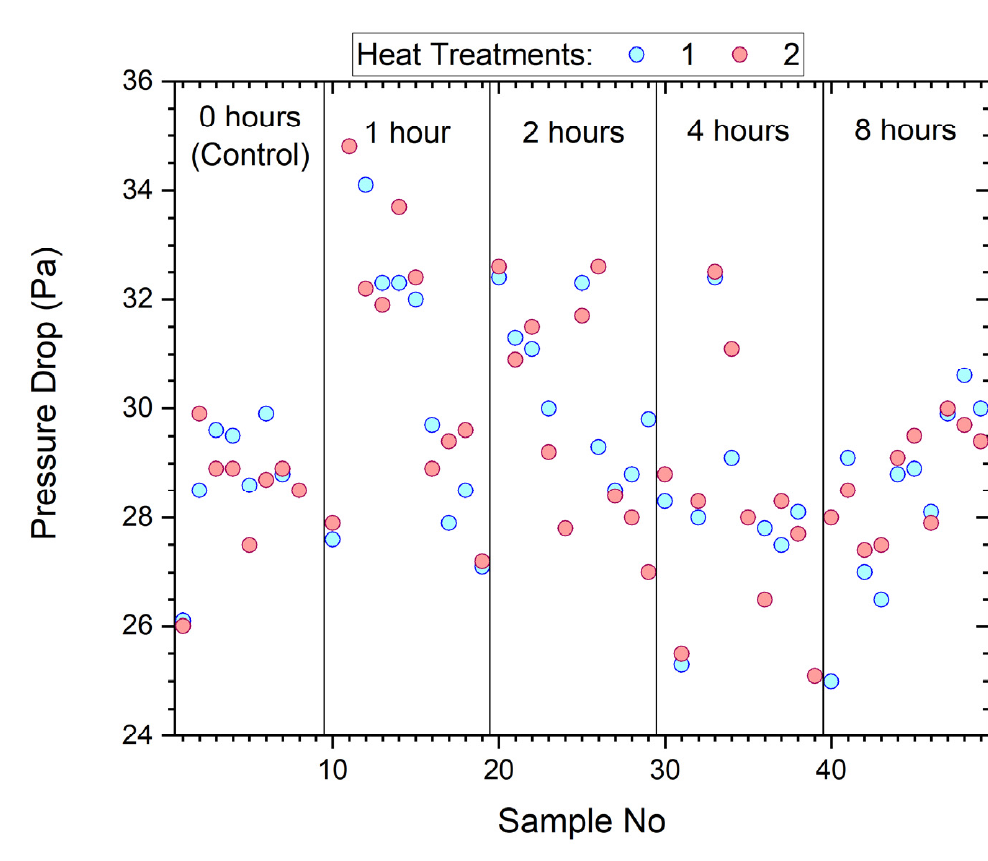
Figure 7. Pressure drop of samples before and after wearing by participants.